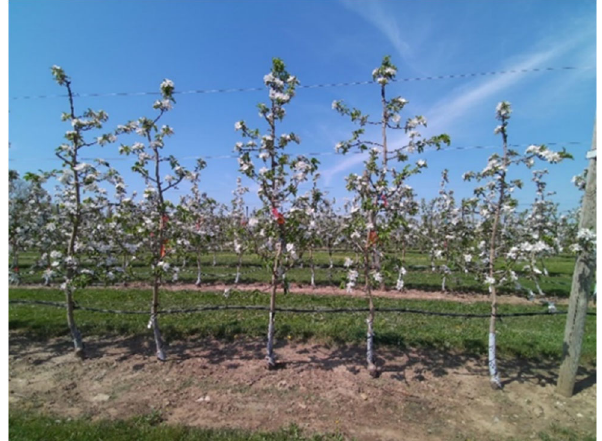
Figure 1. Spacing of the Ambrosia trees at the Simcoe Research Station in Ontario, Canada.